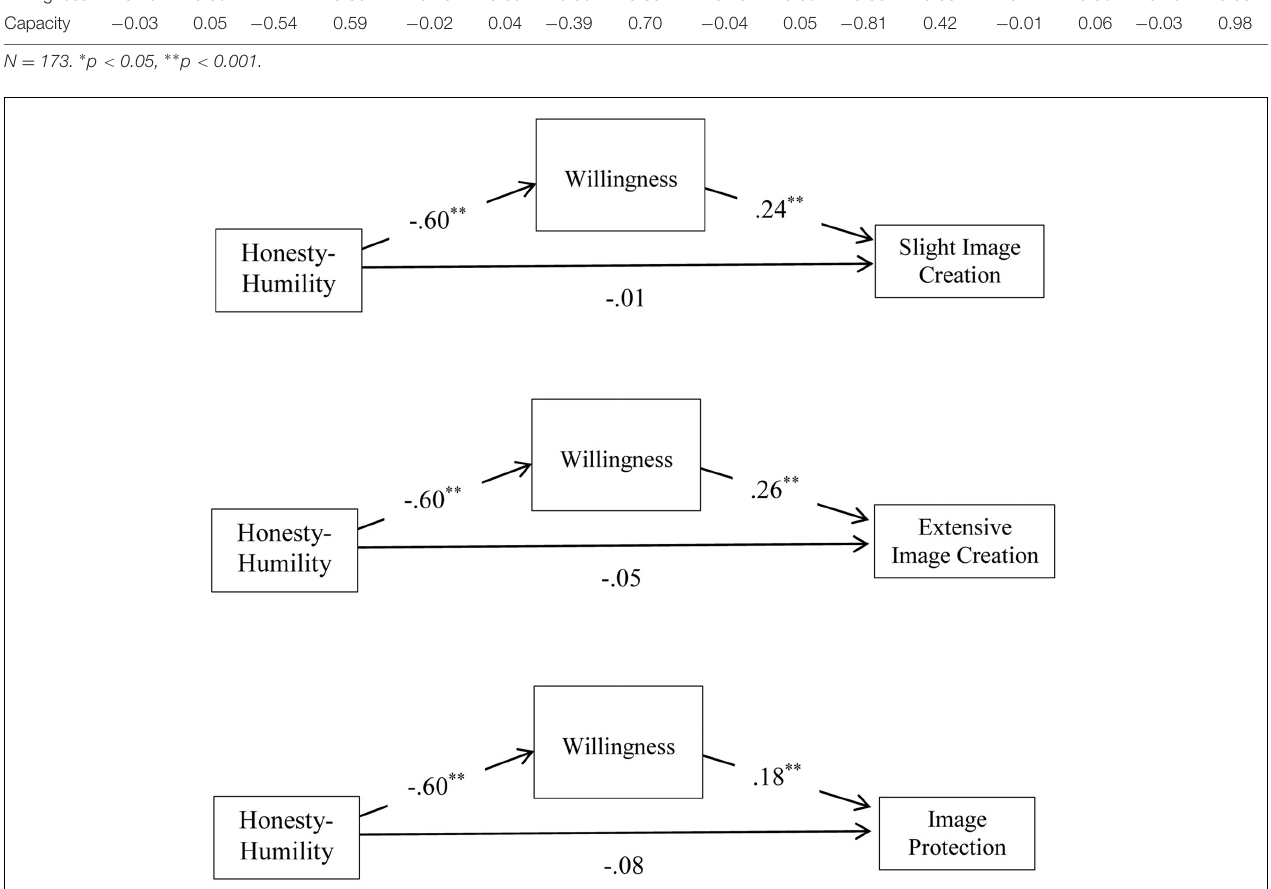
FIGURE 1 | Indirect effects of Honesty-Humility on slight image creation, extensive image creation, and image protection through willingness. ∗∗ p <